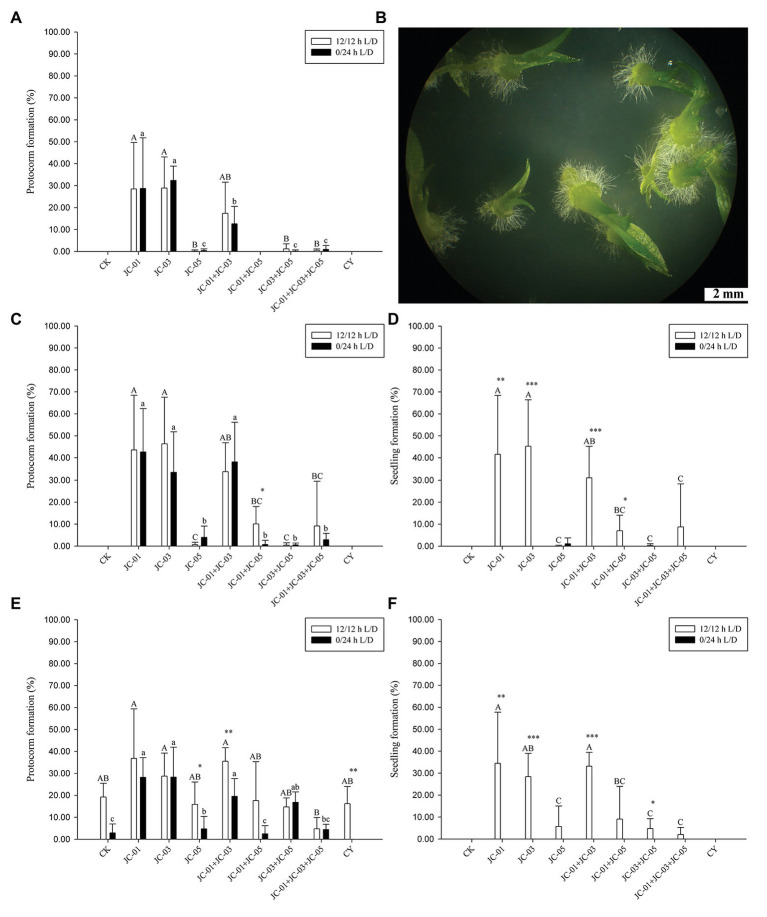
The effects of fungal inoculation and illumination on symbiotic seed germination of D. nobile at different times after sowing. The significance among fungal treatments was shown by different capital letter under light photoperiod conditions and lower case letter under dark conditions. Asterisks denote statistical differences between light/dark treatments according to multiple comparisons (***p < 0.0001, **p < 0.001, *p < 0.05). (A) Protocorm formation at 20 days; (B) protocorms and advanced seedlings with leaves and roots at 90 days; (C) protocorm formation at 50 days; (D) seedling percentage at 50 days; (E) protocorm formation at 90 days; (F) seedling percentage at 90 days. CK, control test; JC-01: MH500251; JC-03: MH500253; JC-05: MH500255; JC-01 + JC-03: dual inoculation by MH500251 and MH500253; JC-03 + JC-05: dual inoculation by MH500253 and MH500255; JC-01 + JC-03 + JC-05: tri-inoculation by MH500251, MH500253 and MH500255; and CY: KM226996.1.